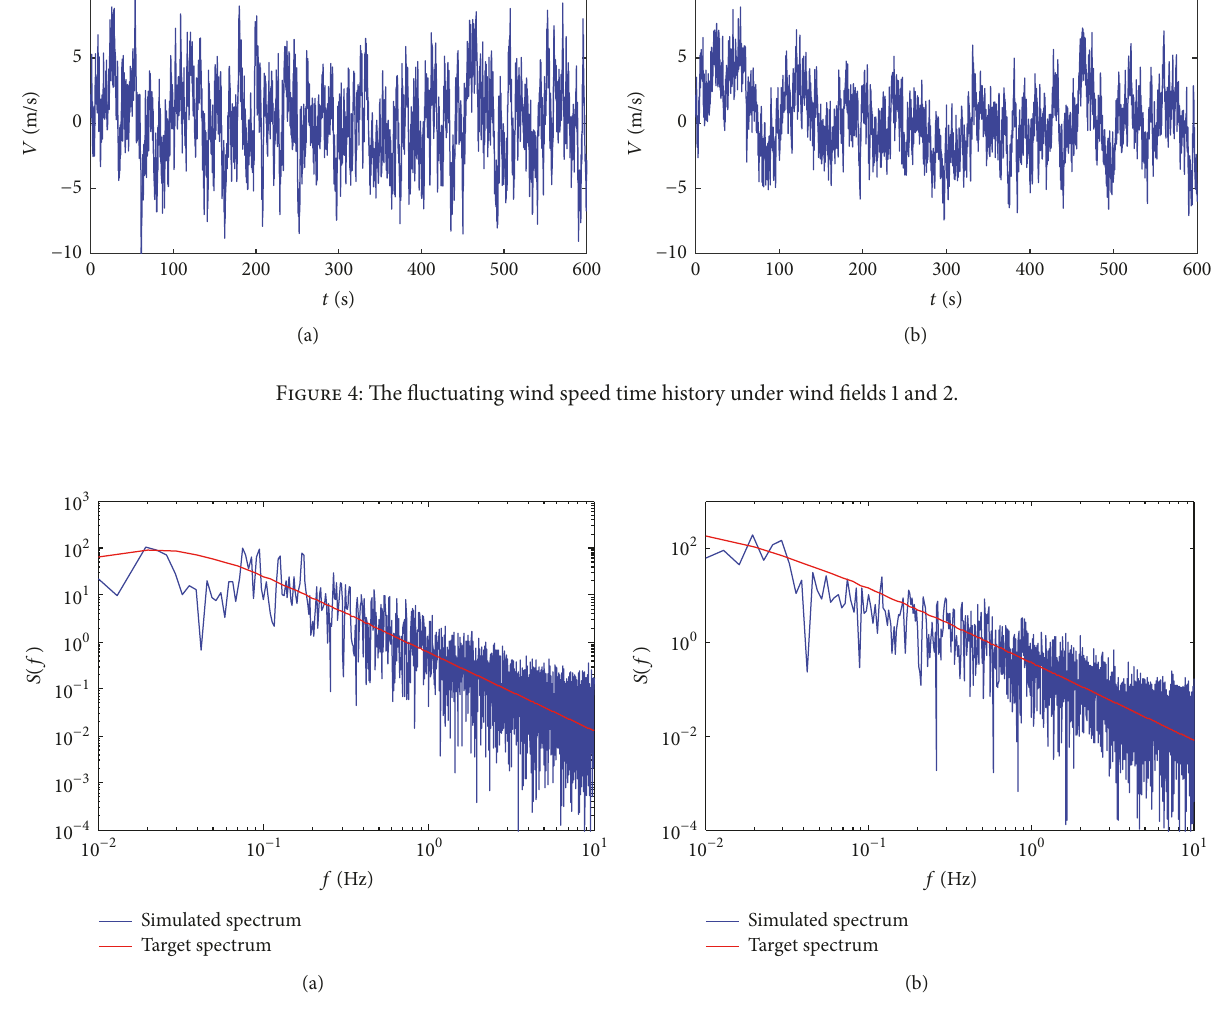
Figure 5: Comparison of the pulsating wind speed spectrum with the target spectrum under wind fields 1 and